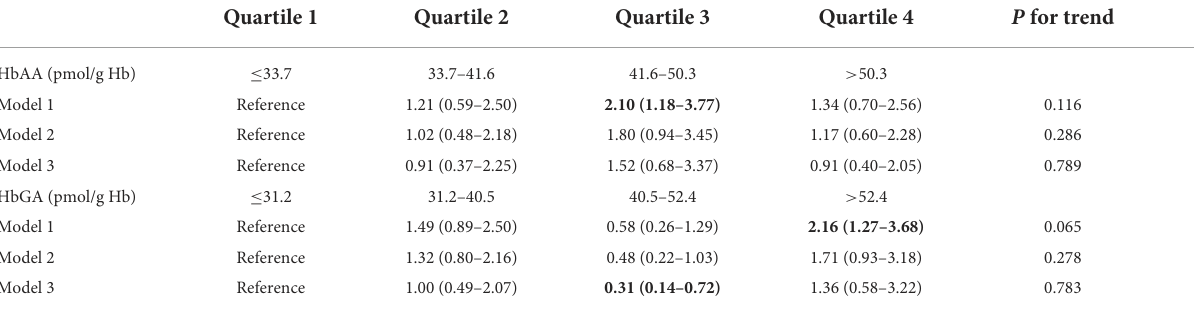
TABLE 2 Odds ratio (95% CI) of developmental disabilities by quartile of HbAA and